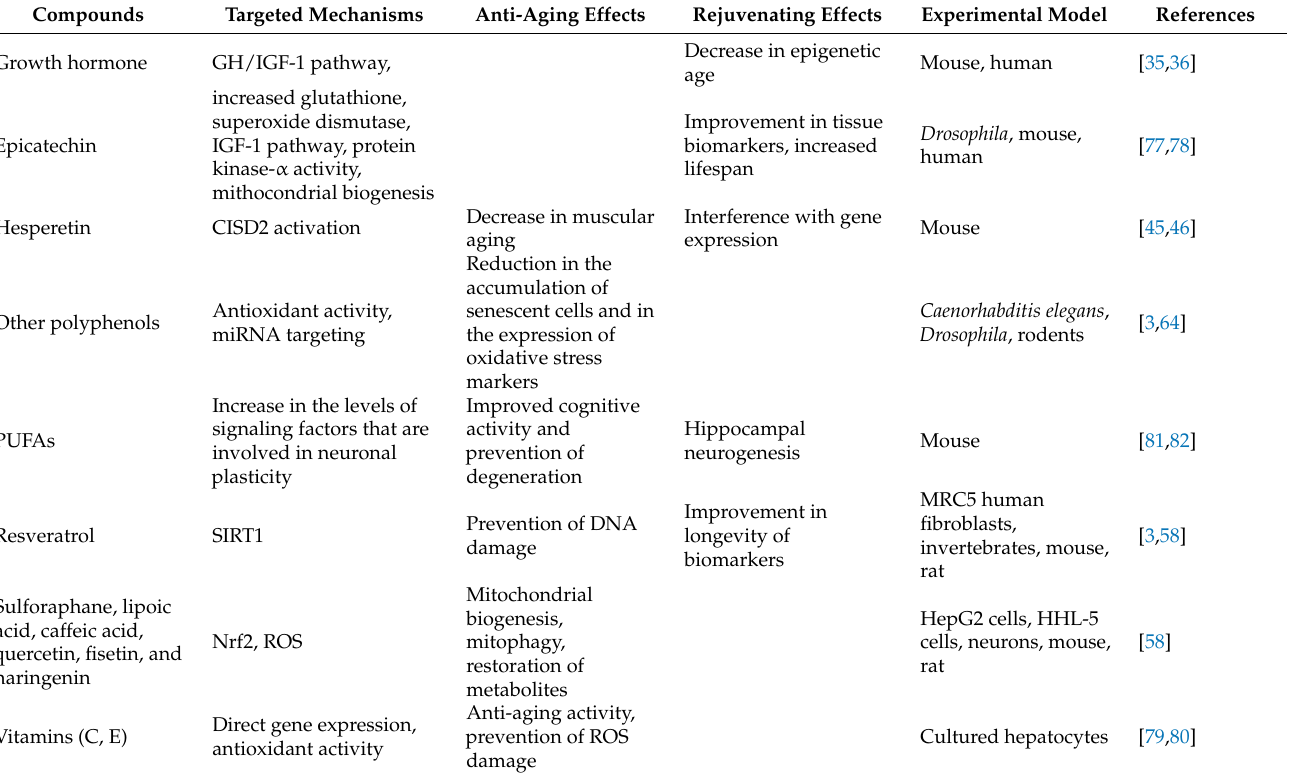
Table 1. Overview of the main anti-aging and rejuvenating effects of the compounds cited in this section, and their molecular